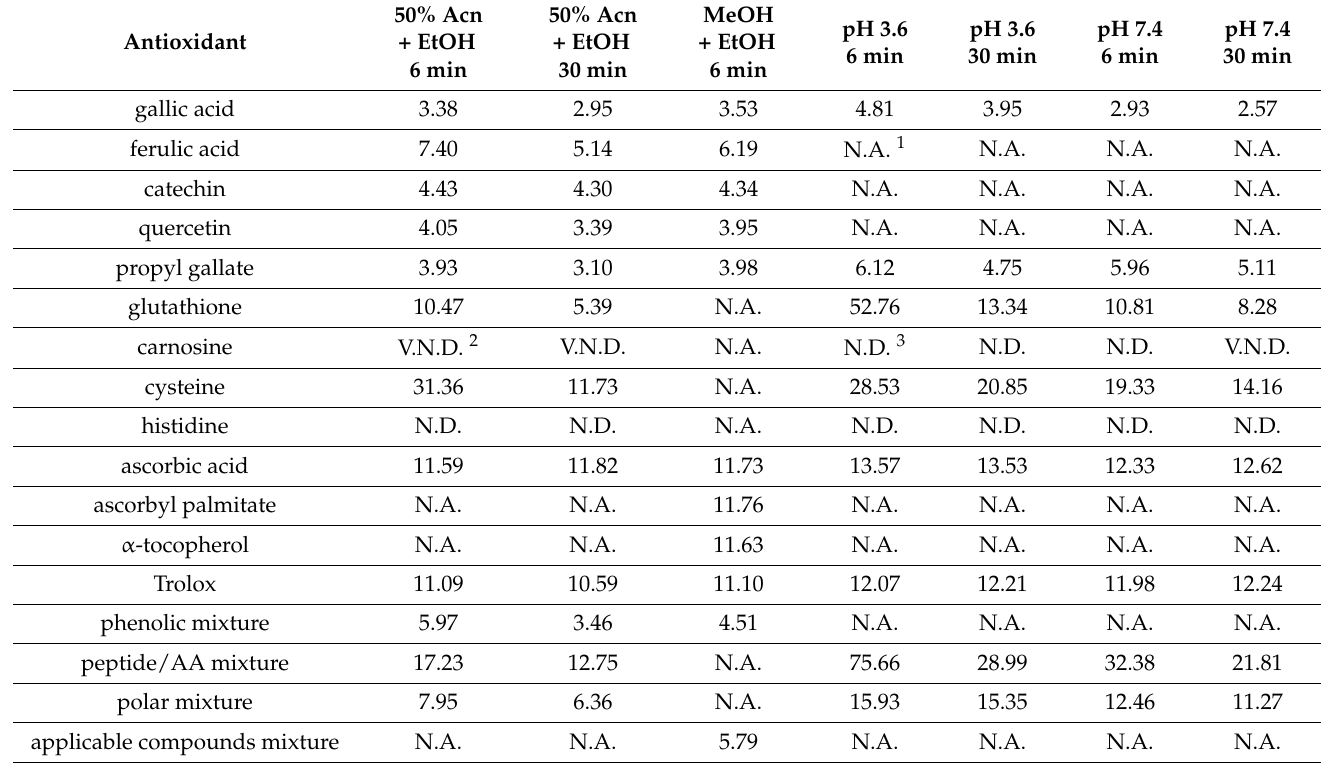
Table 5. IC 50 values ( µ M) determined against ABTS radical cations applied in 50% acetone or methanol (radical solution diluted with ethanol) and buffers of pH 3.6 and 7.4 (radical solution diluted with buffers) after standard and modified reaction